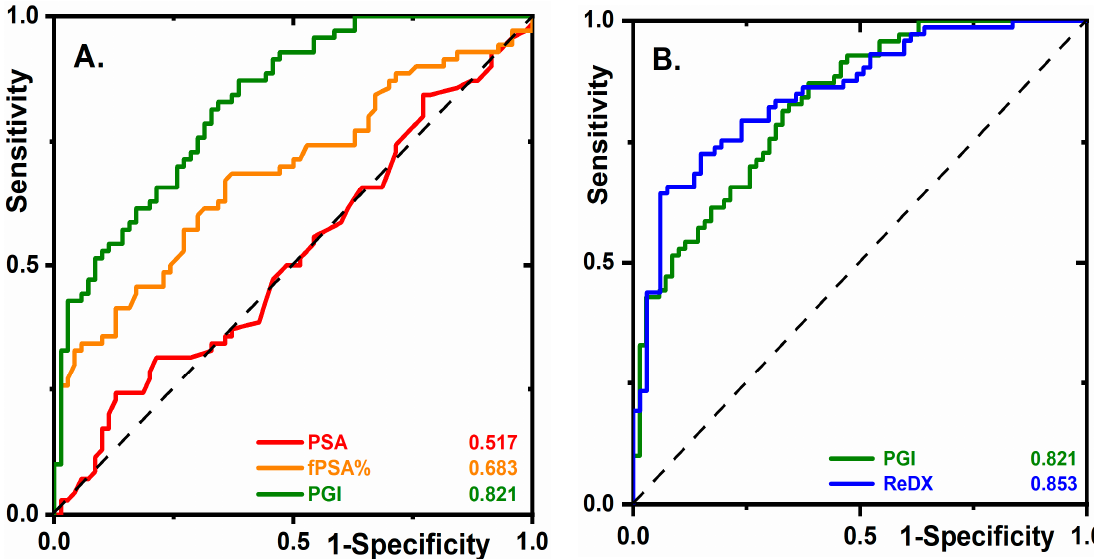
Figure 1. Diagnostic prostate cancer (PCa) biomarkers. ( A ) Receiver operating characteristics (ROC) curves for PSA, fPSA%, and prostate glycan index (PGI) (see Line 17, Table S3) are shown using 140 serum samples (70 samples from non-cancer cohort and 70 samples from PCa cohort). ( B ) ROC curves for PGI and for the case of 3 samples (2 samples with high-grade prostatic intraepithelial neoplasia (HG PIN) and 1 with PCa) being moved from the non-cancer cohort into the PCa cohort (labeled as “ReDX”). For more details, see the text.